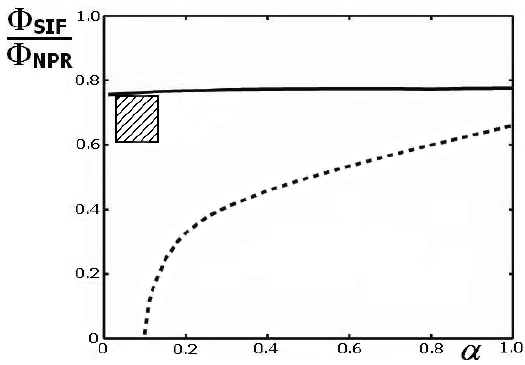
Fig. 11 . Mass transports ratio Φ SIF : Φ NPR computed analytically using the kink model Fig. 11. Mass transports ratio 8 SIF : 8 NPR computed analytically (solid line) and ZNb no-kink model (dashed line). The no-kink coastline has a slant of using the kink model (solid line) and ZNb no-kink model (dashed 37.5 ° , the average of 60 ° (SIF) and 15 ° (NPR). The hatched rectangle shows the line). The no-kink coastline has a slant of 37.5 ◦ , the average of 60 ◦ (SIF) and 15 ◦ (NPR). The hatched rectangle shows the confidence confidence area of the observational data from VSa. area of the observational data from